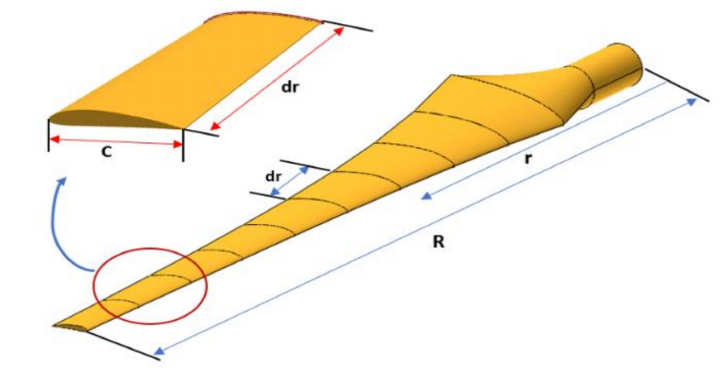
Figure 4. Schematic of blade